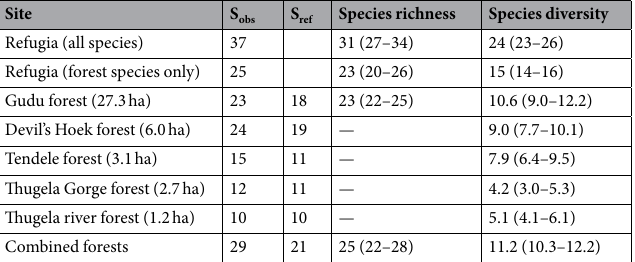
Table 1. The number of observed species (S obs ), rarefied species richness (95% CI) and species diversity measured by the Shannon exponential (95% CI) for 39 refuge sites and five forests at Royal Natal. S ref refers to the number of tree species recorded from forest that were also present on refugia. The number of species was rarefied to 376 individuals, the number of individuals recorded from Gudu forest. Shannon exponential is measured in units of equally abundant species and is thus directly comparable between groups. The 95% confidence interval was calculated using a bootstrap method (200 iterations). Combined forests represents the combined samples (n = 35) for the five forests. Species richness estimates by rarefaction were not calculated for the smaller forests because of the low numbers of trees sampled.